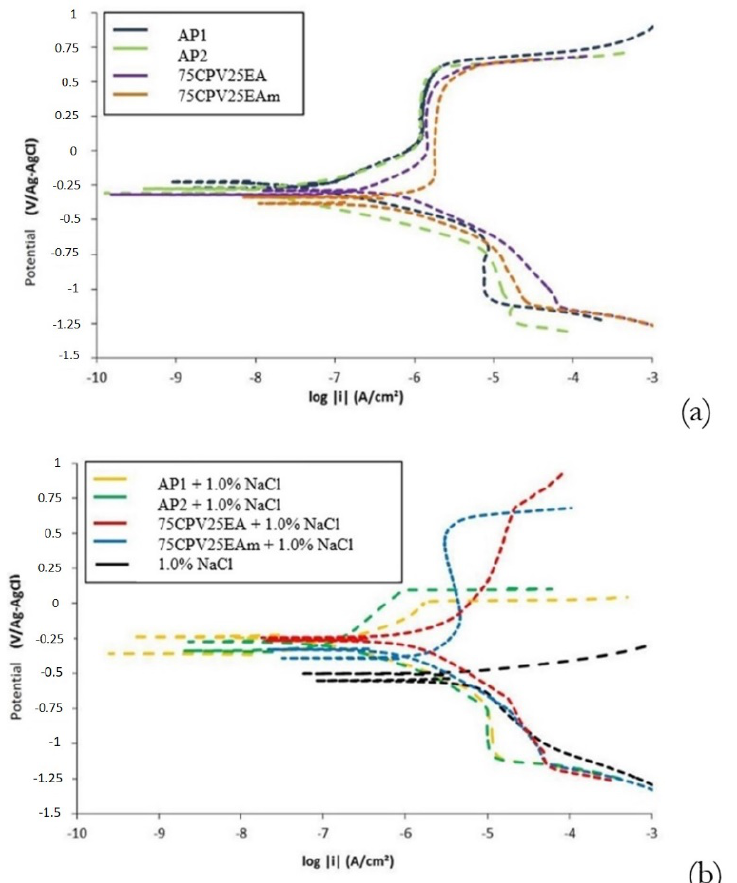
Figure 2. Polarization curves for CA-50 steel in pore water without (a) and with the addition of 1.0% NaCl (b). Each branch of the curves was obtained with a different electrode.